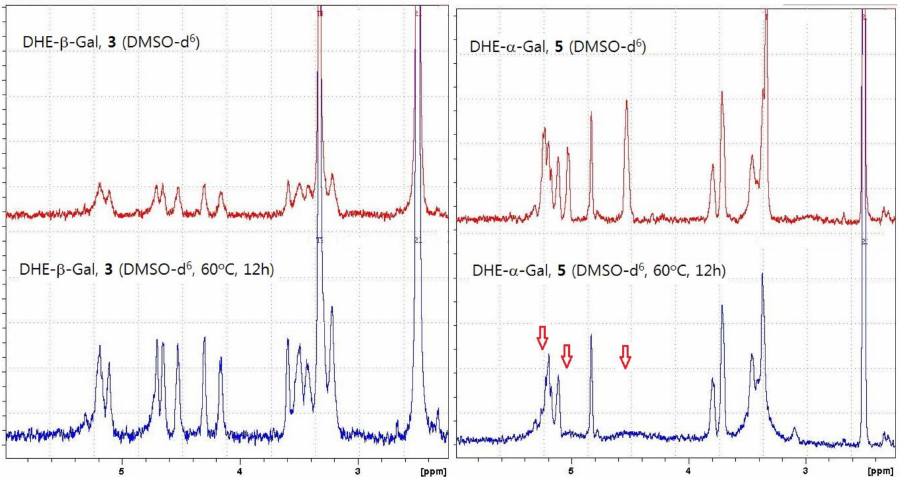
Figure 5. NMR spectra of α - and β -anomers of DHE-Gal ( 3 and 5 ) in DMSO-d 6 at room temperature and 60 ◦